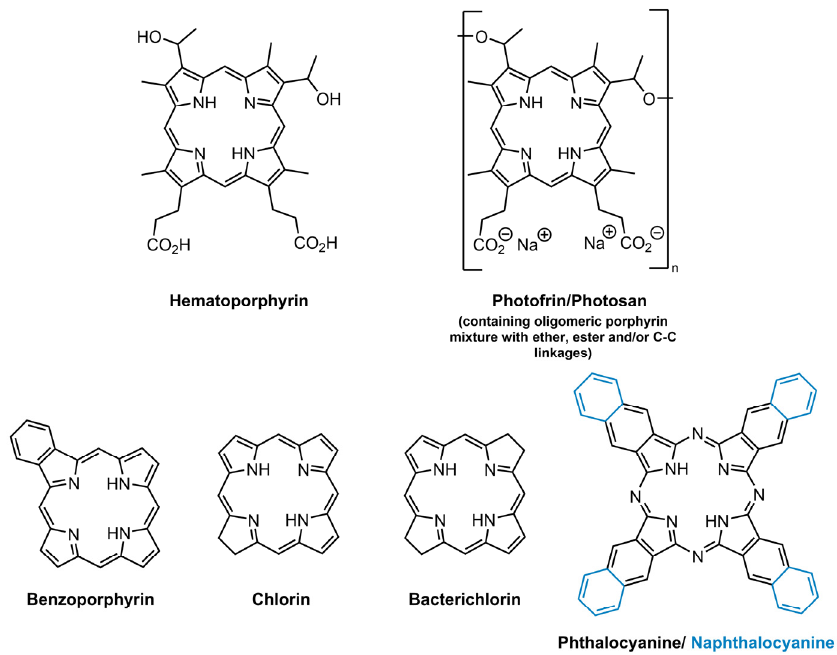
Figure 2. Structures of some first generation PS and the core structure of second generation PS.